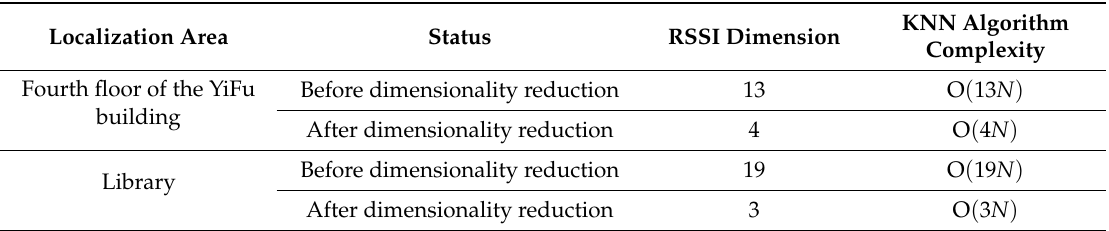
Table 2. KNN algorithm complexity